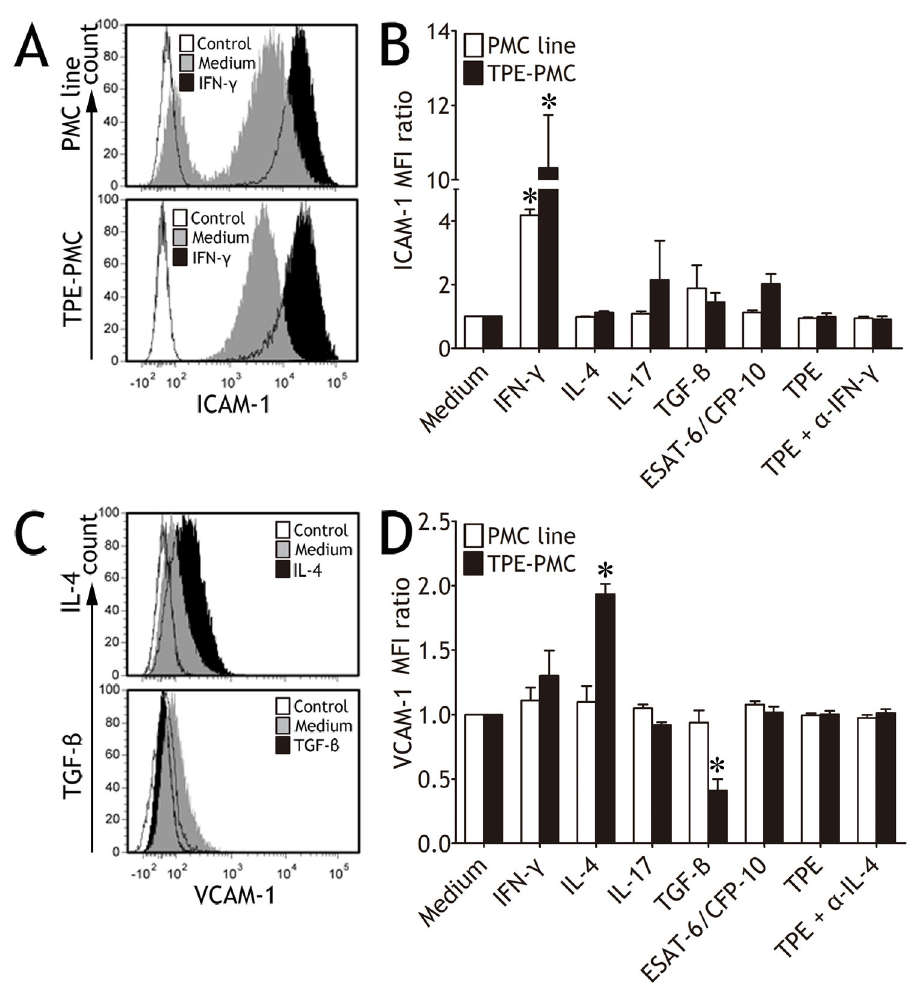
Figure 2. Regulation of expressions of intercellular adhesion molecule-1 (ICAM-1) and vascular cell adhesion molecule-1 (VCAM-1) on pleural mesothelial cells (PMCs) in vitro . A non-malignant transformed mesothelial cell line Met5A cell (PMC line) or PMCs derived from tuberculous pleural effusion (TPE) were cultured in medium alone, designated cytokines, tuberculosis- specific antigens (ESAT-6/CFP-10), or 50% volume TPE in the absence or presence of anti ‒ IFN-γ or ‒ IL-4 mAbs. After 48 h, PMCs were stained and detected by flow cytometry. (A) Representative cytometric histograms show ICAM-1 expression on PMC line and PMCs from TPE cultured in medium alone or stimulated by IFN-γ. White histograms indicate isotype controls. (B) Comparisons of ICAM-1 MFI ratios of PMCs are shown. ICAM-1 fluorescence intensity (MFI) ratios were calculated by dividing MFI of each group by MFI of control group, respectively. (C) Representative cytometric histograms show VCAM-1 expression on PMCs from TPE cultured in medium alone, stimulated by IL-4 or TGF-β. White histograms indicate isotype controls. (D) Comparisons of VCAM-1 MFI ratios of PMCs are shown. In panels B and D, the results are reported as mean ± SEM from 5 independent experiments. The comparisons were determined by Kruskal-Wallis one-way analysis of variance on ranks. *p < 0.05 compared with the corresponding